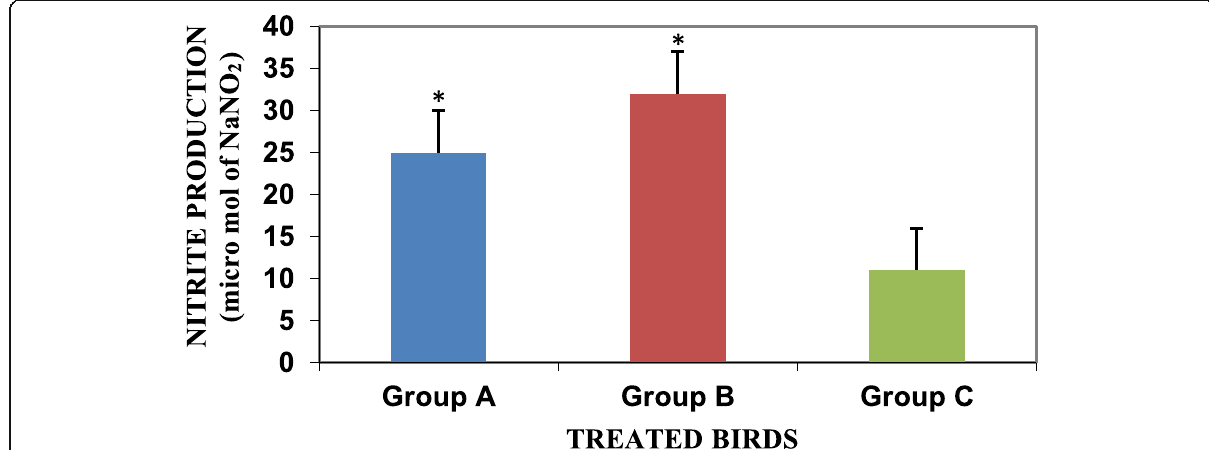
Fig. 3 In vitro NO 2 − production assay of intestinal intra-epithelial leukocytes (iIEL) of MG-fed and control broiler birds after challenge with ND